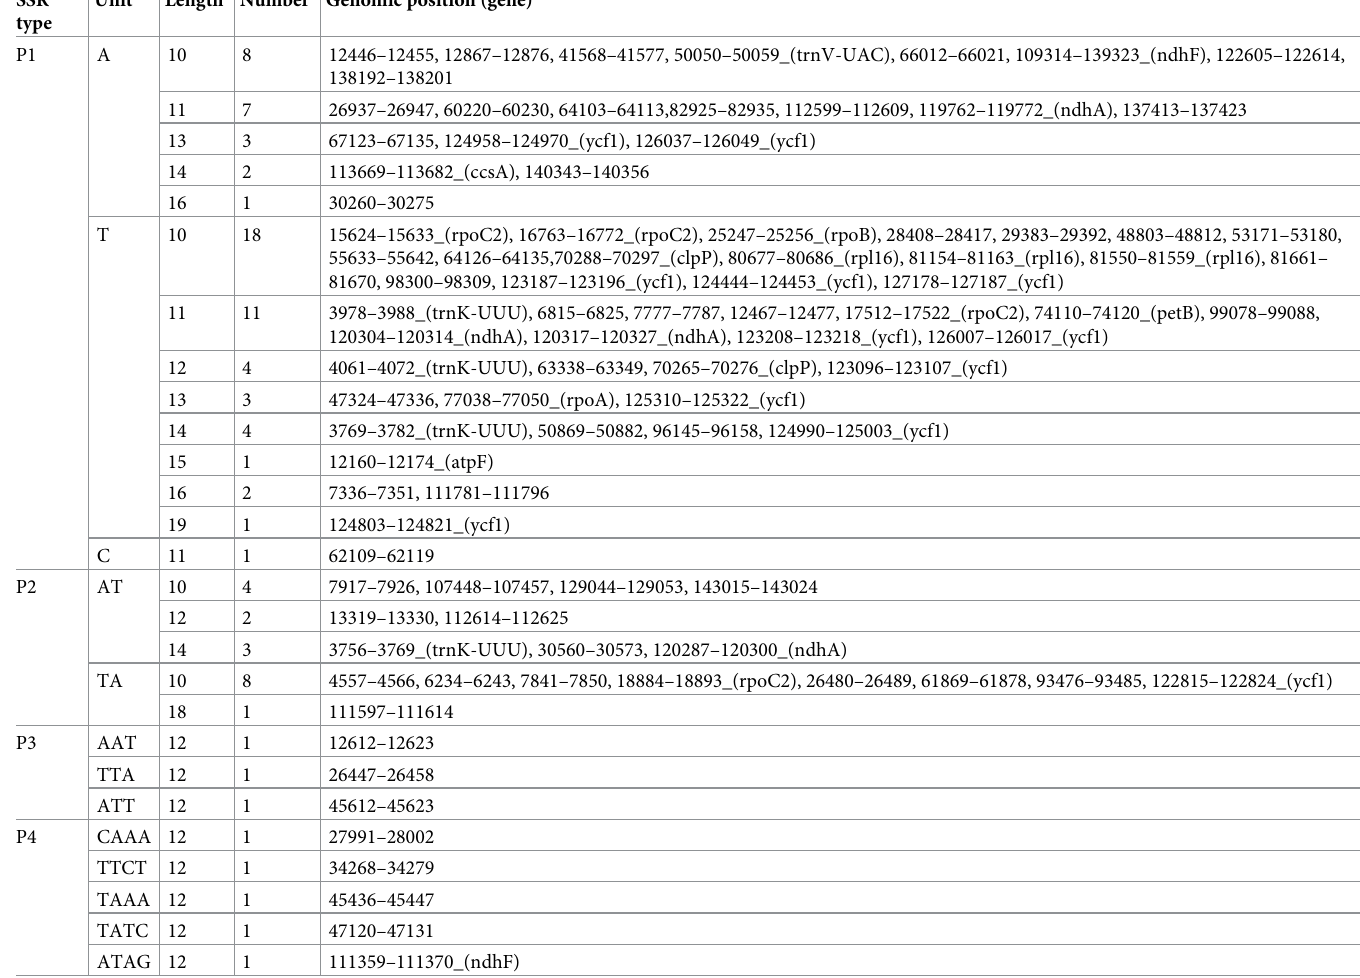
Table 9. Distribution of SSRs in the broccoli cp